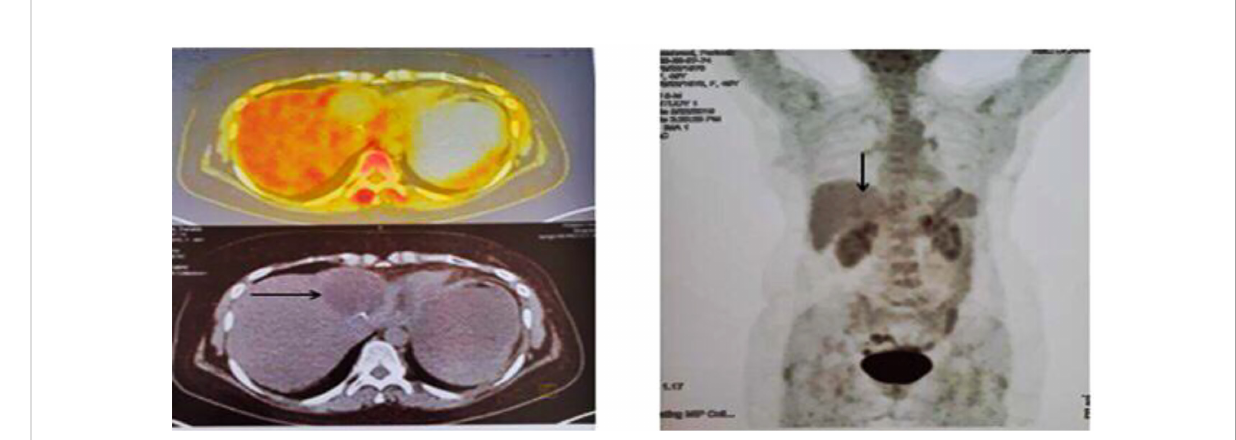
FIGURE 3 Second PET/CT on 23 May 2019. When compared with prior FDG PET/CT scan, the patient status post left liver lobe segment 4 resection, with non-FDG-avid post-surgical change in the surgical bed, which was compatible with an excellent complete metabolic response to